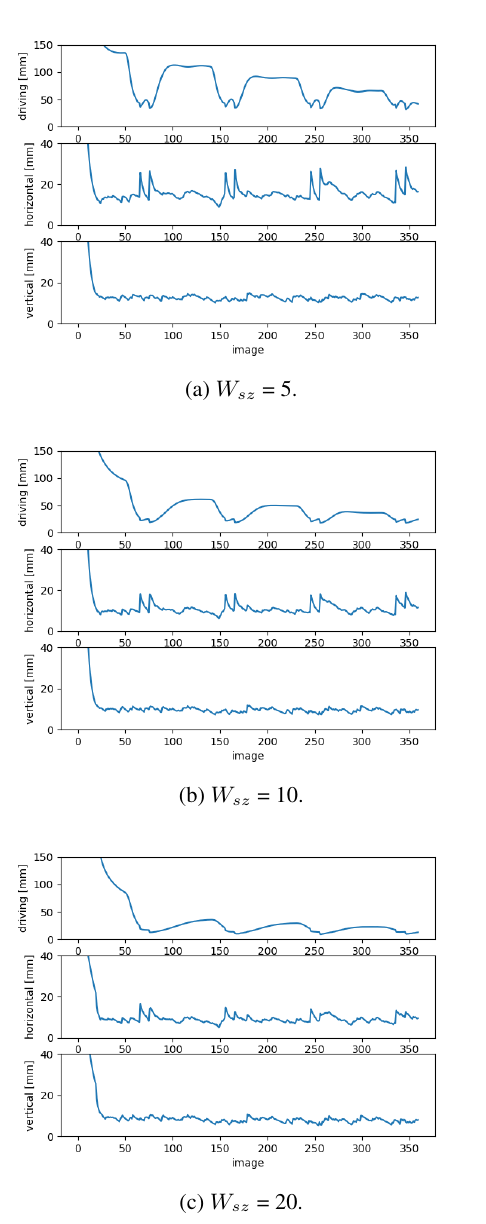
Figure 9. Precision of the position in the vertical and the horizontal image axes and the driving direction with W sz 10, 20 and 30. Note that the scale of the driving direction is adapted to better visualize the results.